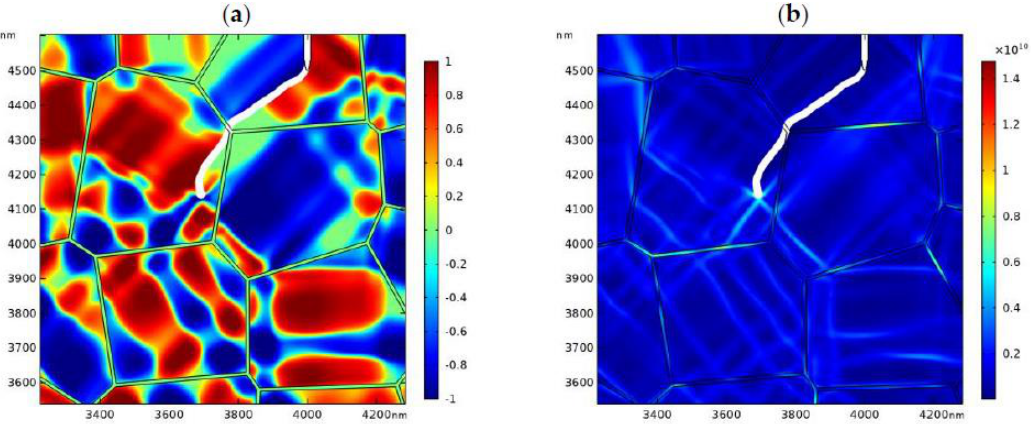
Figure 9. The local phase pattern ( a ) and the local von Mises stress field ( b ) just before crack branching (Figure 8d).